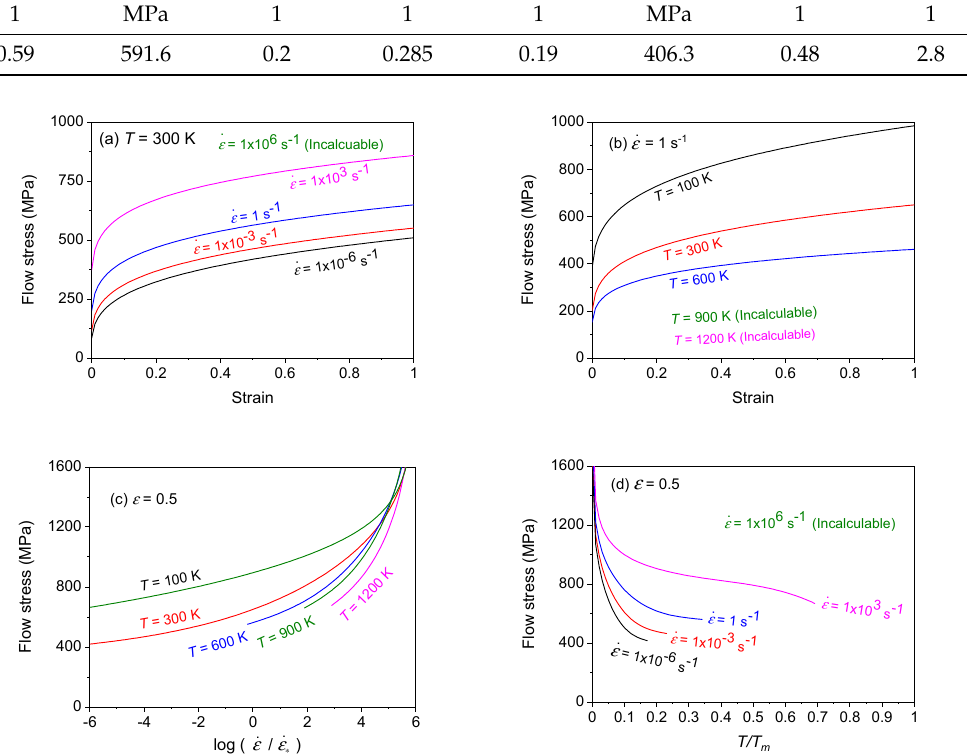
Figure 15. Flow stress–strain curves predicted for mild steel ES using the RK model ( a ) at 300 K for different strain rates and ( b ) at 𝜀(cid:4662) = 1 for different temperatures. Change in flow stress at 𝜀 = 0.5 ( c ) with log ( 𝜀(cid:4662) / 𝜀(cid:4662) ∗ ) for different temperatures and ( d ) with T / T m for different strain rates ( 𝜀(cid:4662) ∗ = 1 s − 1 , ε LB = 10 − 6 s − 1 , ε UB =10 6 s − 1 , and T m = 1793 K).